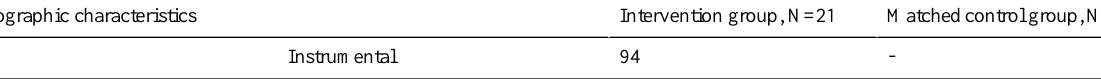
Table 2. Baseline technology use of study participants (N=21).